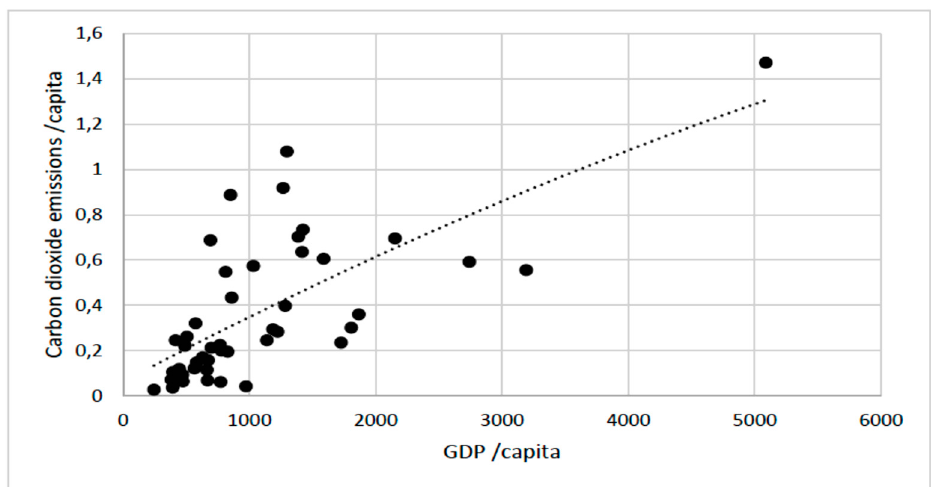
Figure 3. Graph depicting the results of the regression, i.e., model 3. The emission of CO 2 per capita is plotted on the X-Axis, while the GDP per capita is plotted on Y-Axis.